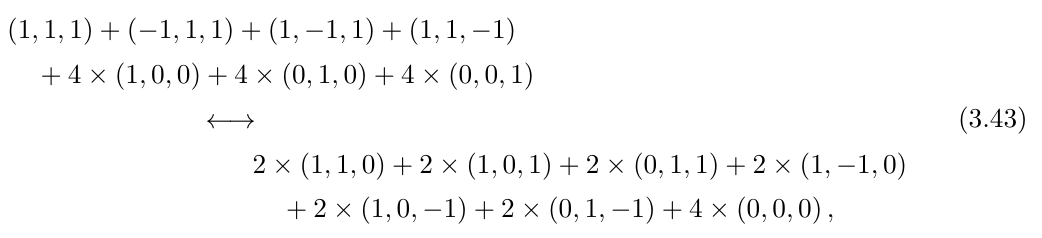
Figure 3 . Plot of the ( b 11 ; b 22 )-plane for a U(1) (cid:2) U(1) model with T = 0. Choices of b 11 ; b 22 for which the AC equations have non-negative solutions with only generic matter (either with the (2 ; (cid:0) 1) ; ( (cid:0) 1 ; 2) or the (2 ; 1) ; (1 ; 2) pair of charge combinations) are shaded in solid blue. Integer choices of b ii for which there is such a solution with integer b ij are superimposed in black. Below the dashed curve b 11 + b 22 = 24, all choices of b ii that yield any good solutions of the AC equations lie within the blue shaded region, and within this region, there is a good solution with one of the two above subsets of generic matter for all j b 12 j (cid:20) min( b 11 ; b 22 ) = 2. is an